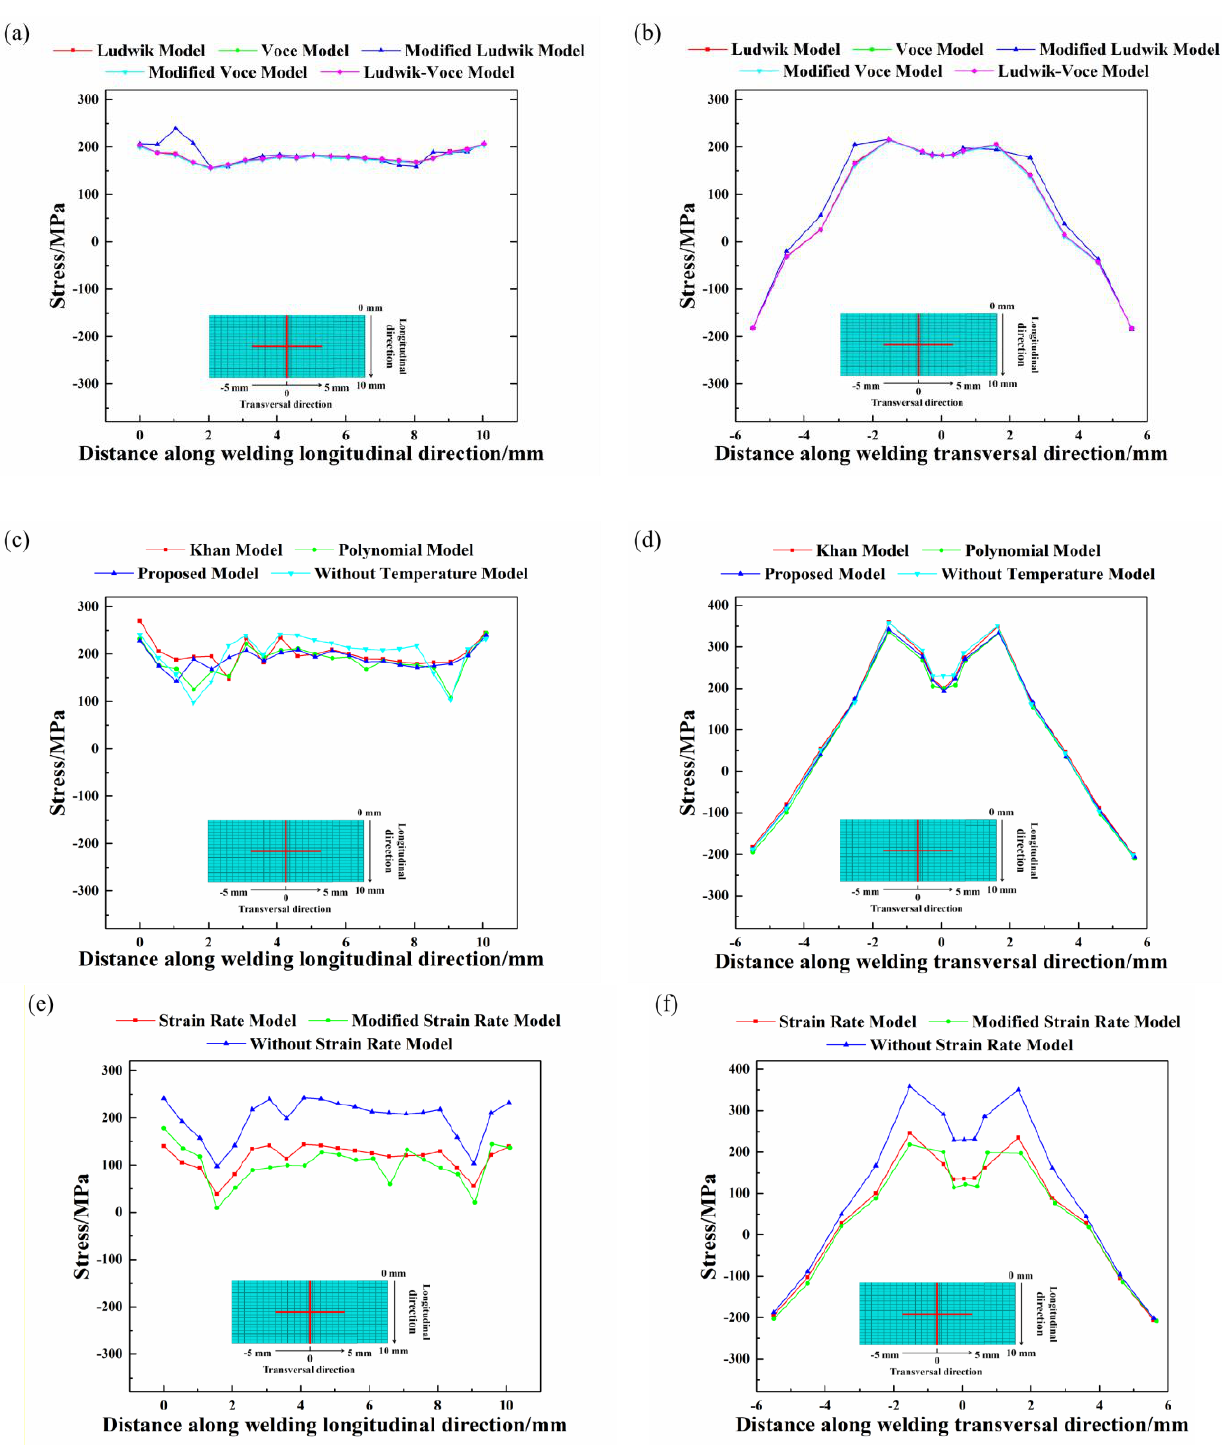
Figure 14. Laser welding residual stress for ( a ) longitudinal for strain models, ( b ) transversal for strain models, ( c ) longitudinal for temperature models, ( d ) transversal for temperature models, ( e ) longitudinal for strain rate models, ( f ) transversal for strain rate models.